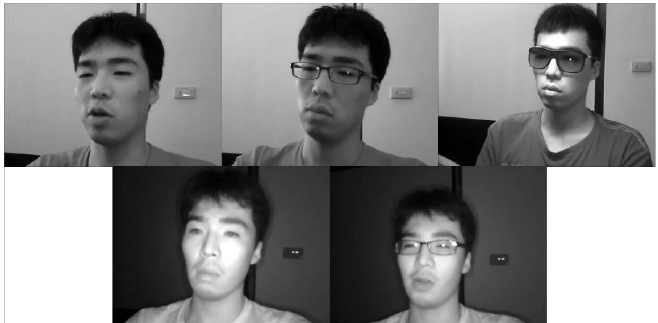
Figure 2. Frame samples of five scenarios in the NTHU-DDD dataset. The images in the first row are sample frames taken in daylight, and from left to right are the no-glasses, glasses, and sunglasses scenarios, respectively. The images in the second row are sample frames taken at nighttime.